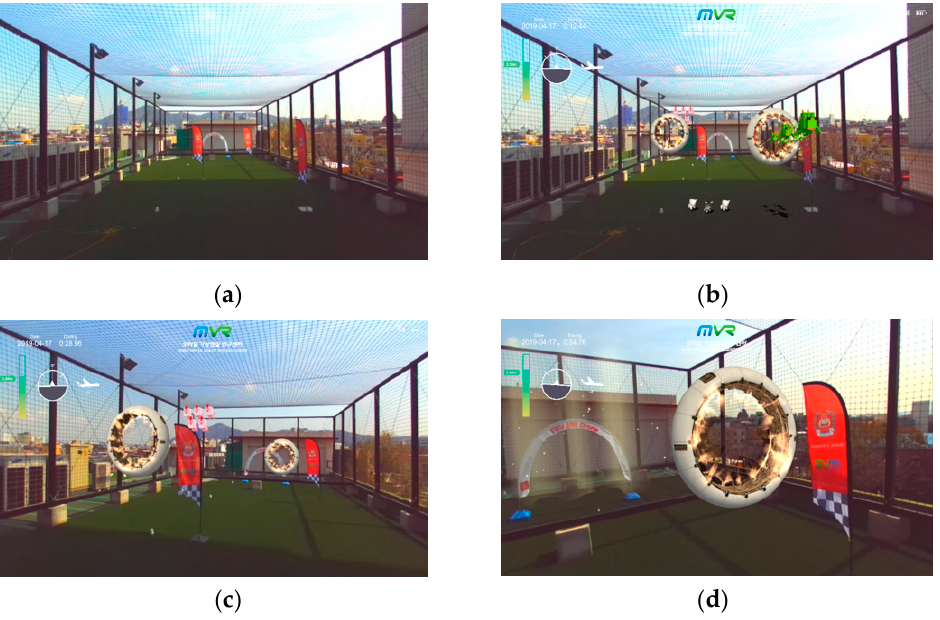
Figure 7. ( a – d ) First-person view (FPV) drone flight images in a time sequence within an aerial mixed-reality (MR) environment.